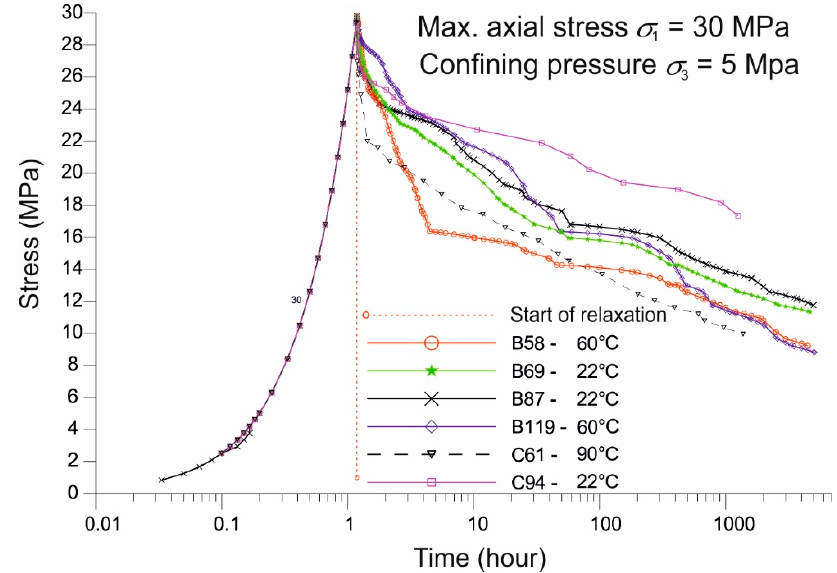
Figure 20. Steady-state creep rate of the Brown and Red Zuber unit samples, depending on the water- insoluble minerals content.